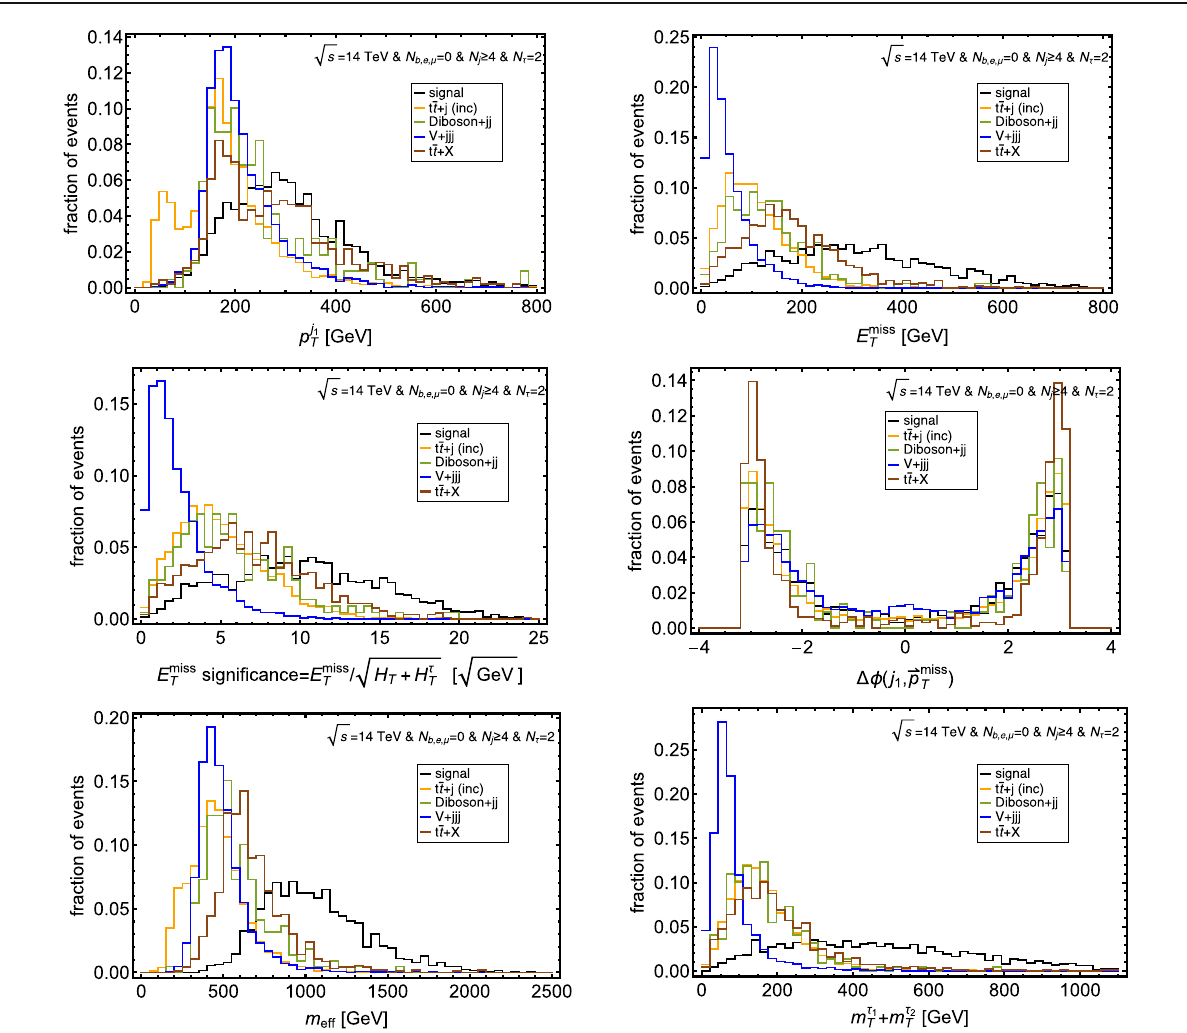
Fig. 3 DistributionsafterselectioncutsinEq.2ofthefractionofsignal and background events of the transverse momentum of the leading light jet p j 1 (upper left panel), the missing transverse energy E miss T